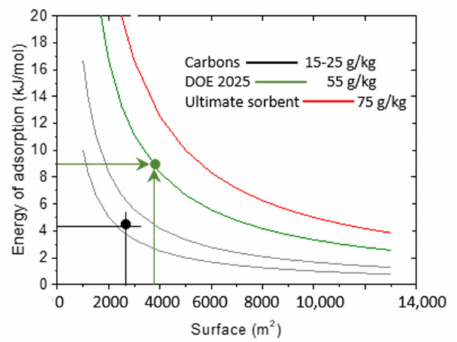
Figure 8. Iso-weight weight-capacity curves (G, in g of H 2 per kg of sorbent) for G values typical of high surface activated carbons and the DOE ultimate goal. The intersections of the lines with G curves indicate the required surfaces (horizontal lines) and average binding energy (vertical lines) to achieve different storage